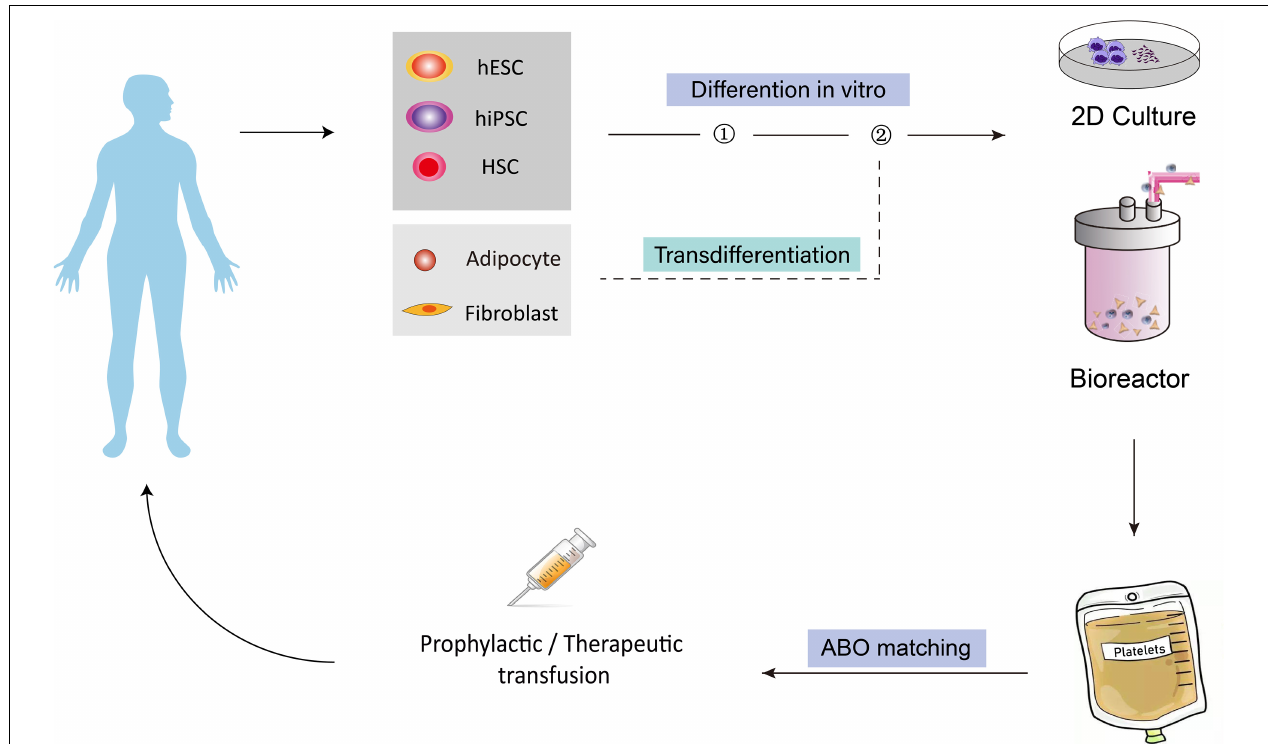
FIGURE 1 | Overview of the concept of generating human platelets in vitro for clinical applications. Different cell types, including HSCs, hESCs, hiPSCs, fibroblasts and adipocyte-derived cells, could be induced to differentiate into MkPs/MKs, then bioreactors could be introduced to produce platelet from MK on a larger scale for transfusion purpose. The generated platelets could finally be injected into human for platelet-related diseases. HSCs, hematopoietic stem cells; hESCs, human embryonic stem cells; hiPSCs, human induced pluripotent stem cells; MkPs, megakaryocyte progenitors; MKs,